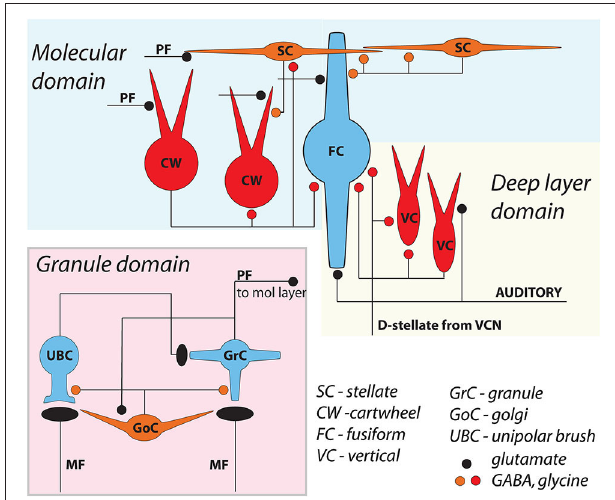
FIGURE 1 | General circuit diagram of the DCN, divided into three computational domains . The auditory domain comprises the auditory input to fusiform cell basal dendrites, and its modification by vertical and D-stellate interneurons. The non-auditory domain receives mossy fiber input to granule cells, and is modified by Golgi and unipolar brush cells. The molecular layer domain comprises the parallel fiber input from granule cells, terminating on fusiform cell apical dendrites and onto cartwheel and SSC cells, both of which in turn control fusiform activity. Omitted here are the giant cells, whose local synaptic circuitry is not well